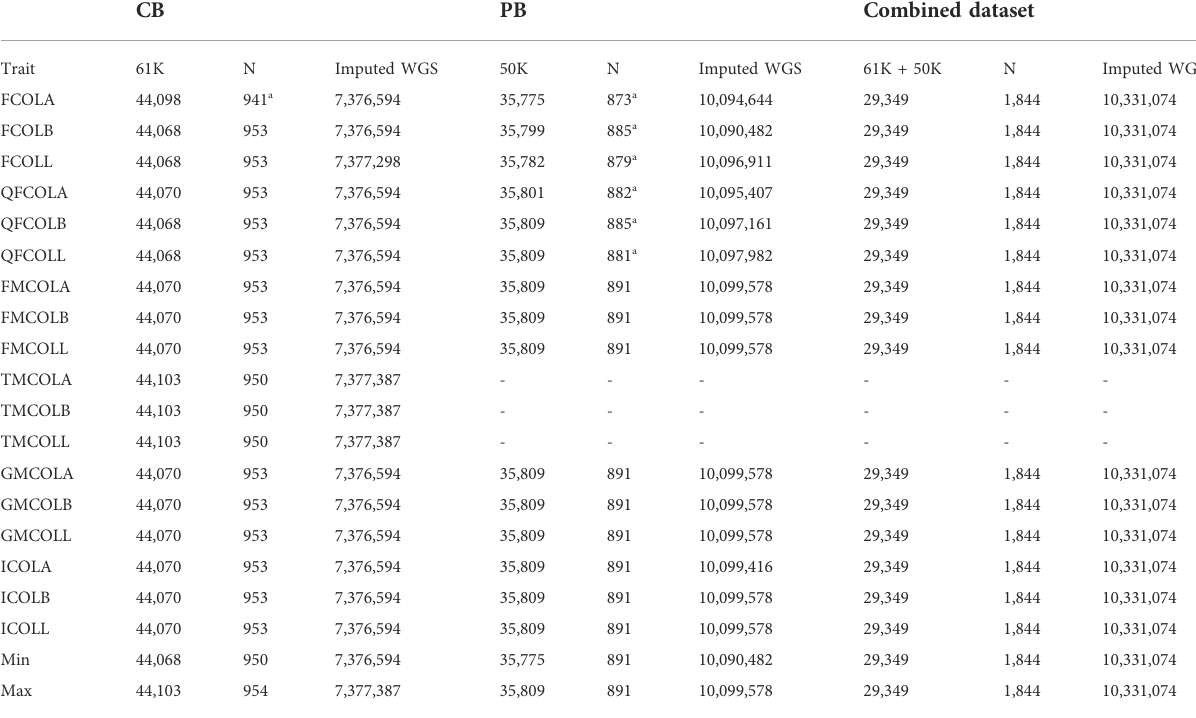
TABLE4NumberofindividualsandSNPsusedforGWASafterqualitycontrolfordifferentdatasets(61KgenotypesofCBs,50Kgenotypes ofPBs,and Combined